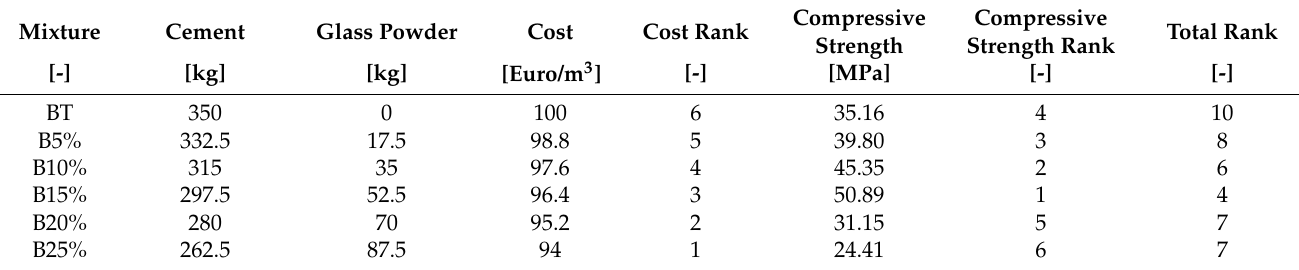
Table 7. Cost and decision ranks of the cementitious composites with waste glass